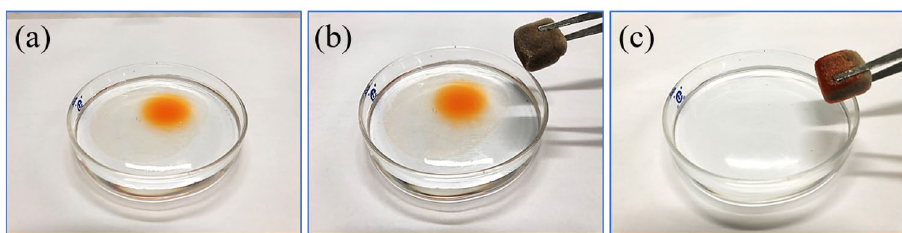
Figure 14. Oils dyed with Sudan III were absorbed by OTS-PDA-MS on the surface of